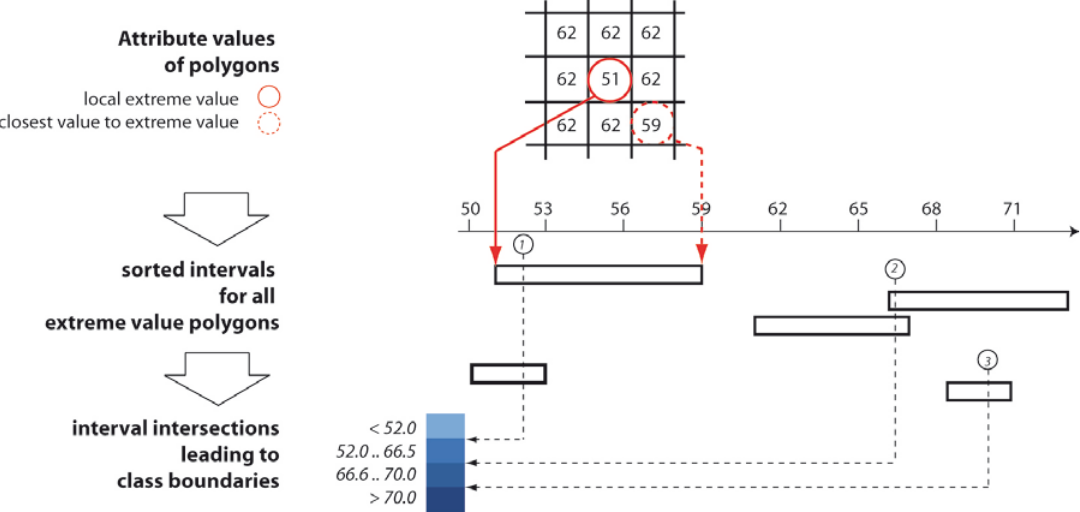
Figure 3. Schematic workflow for preserving local extreme value polygons: Determination of intervals and setting of class boundaries.